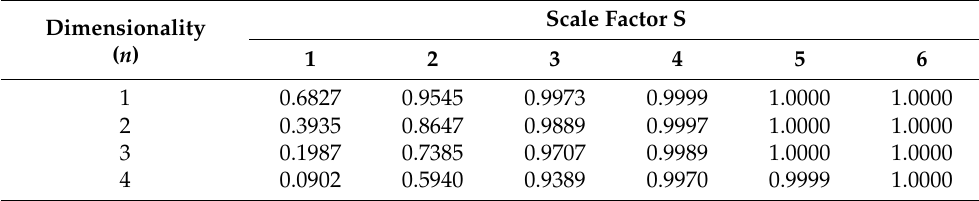
Table 1. Confidence level of scaled SDE for different scaling factors and dimensions [9].